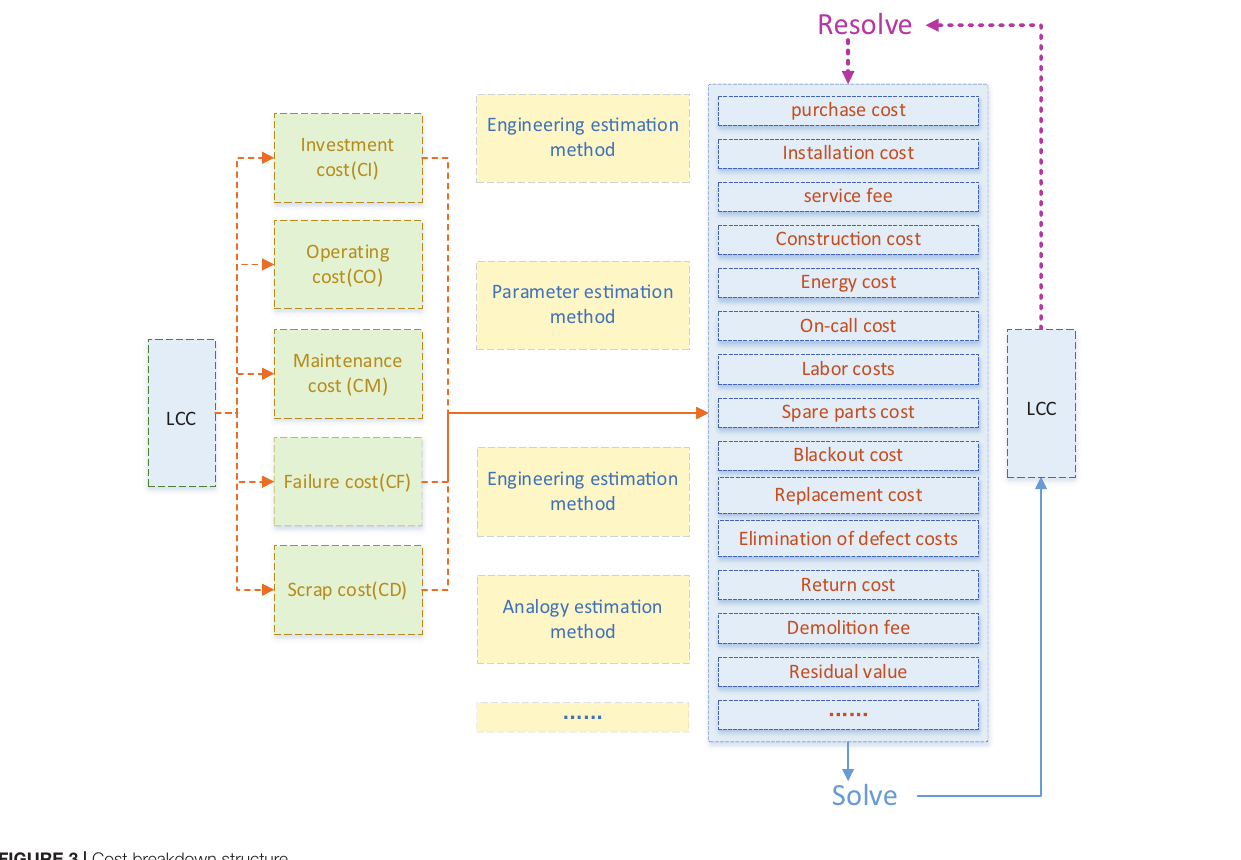
FIGURE 3 | Cost breakdown